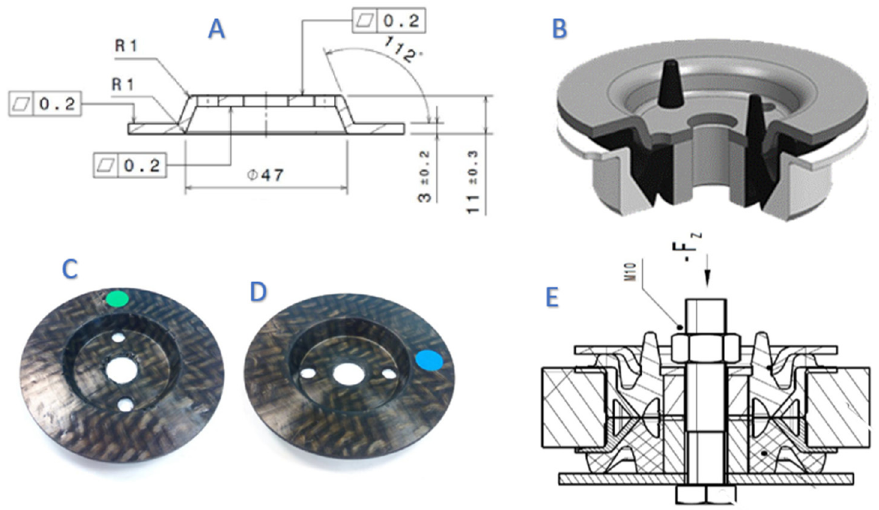
Figure 9. Gear mount prototype. 2D Drawing ( A ). 3D Design ( B ). Specimen CFRTP 3 mm ( C ). Specimen PAF6 FG45 (2.5 mm) ( D ). Assembly ( E ).